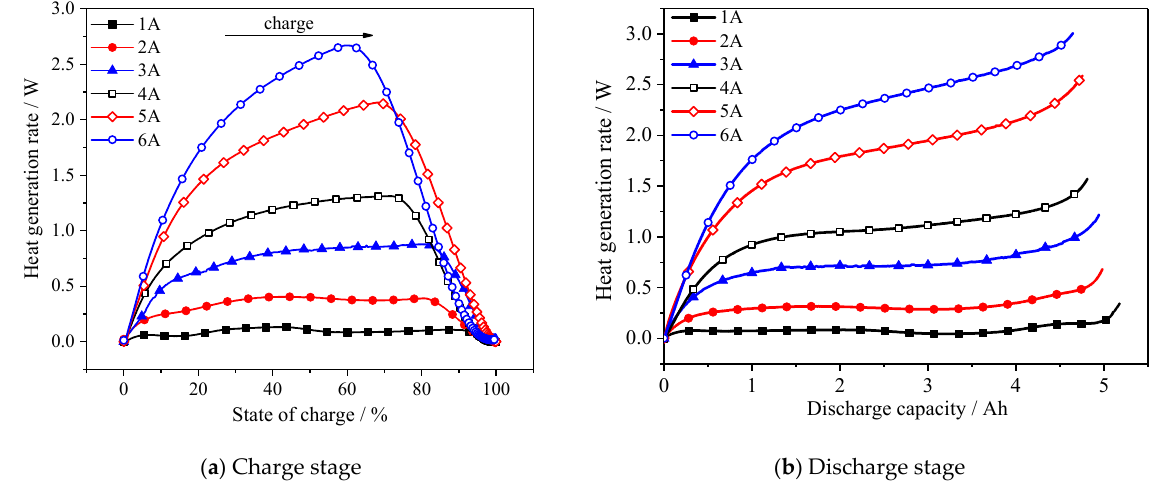
Figure 2. Effect of operating current on the heat generation rate during the charge and discharge stage of a NCM battery, at isothermal ambient temperature of 25 °C.